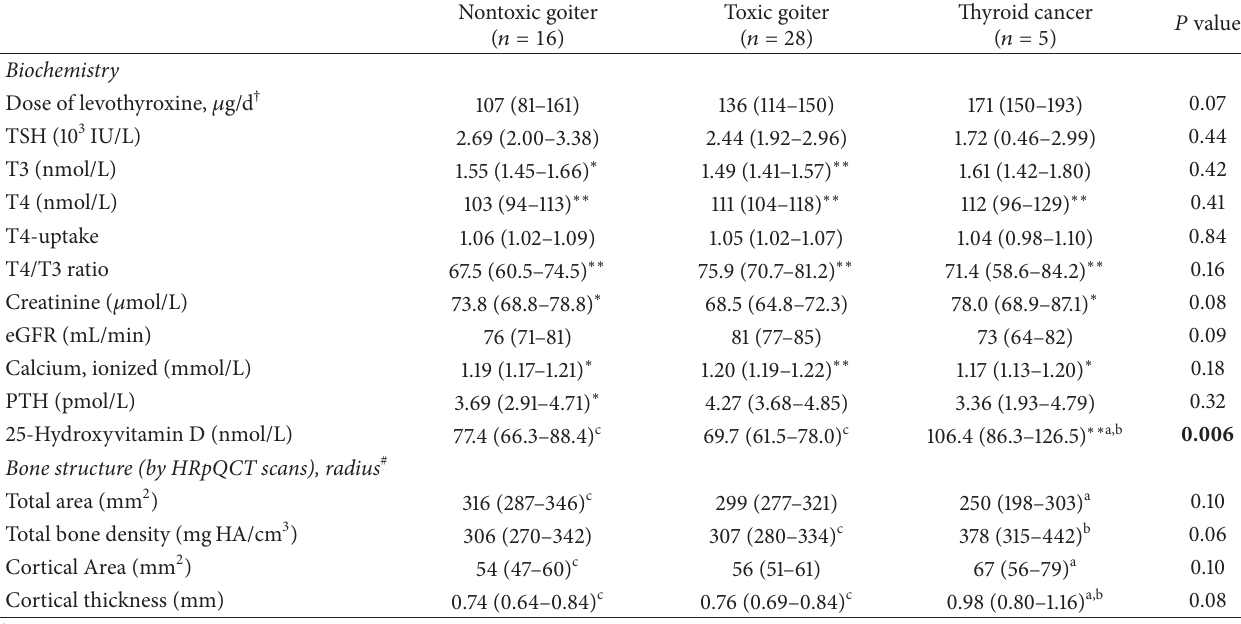
Table 3: Characteristics of studied patients stratified by etiology of thyroid disease. Tests were performed by univariate ANOVA, adjusted for gender, age, and BMI. 𝑃 values are based on 𝐹 -tests. Mean values with 95% confidence